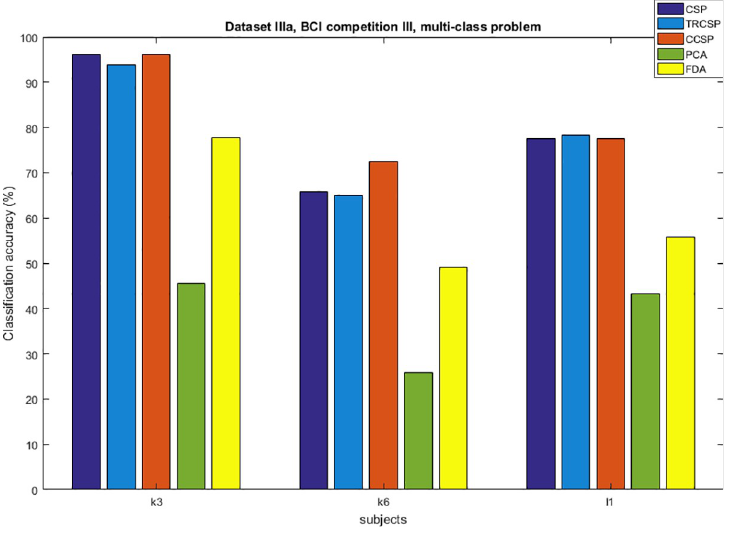
Fig 5. Comparison between classification accuracy of methods for multi-class problem in dataset IIIa, BCI competition III.